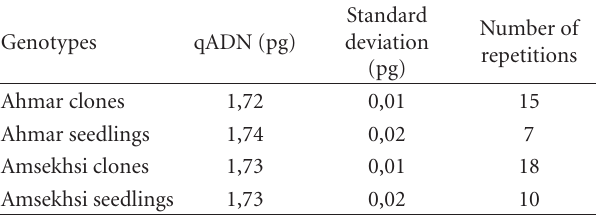
Average values were calculated from 5 repetitions per condition of medium; letters indicate significative di ff erences according to Newman and Keuls test at the level of 5%. Table 3: Quantification of nuclear DNA from cells of leaf tissue of seedlings and clones produced from cell suspensions in cultivars Ahmar and Amsekhsi.